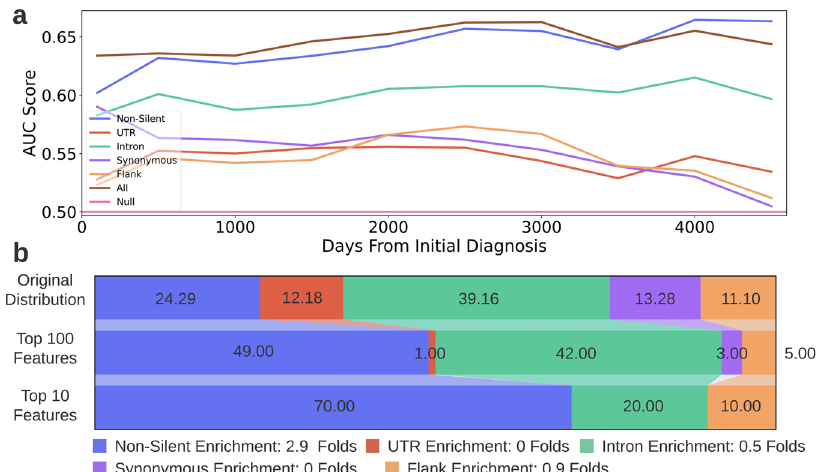
Fig. 9 Survival estimation results. a AUC scores achieved by the six RSF models for various times after the initial cancer diagnosis. The x -axis depicts the days passed since the diagnosis and the y -axis depicts the AUC score achieved by the models. Each colored curve denotes a different dataset. The horizontal line depicts the AUC score of a null model. b Feature-type distribution of the all features dataset and of the top ranked features chosen in the survival probability estimation task. Feature-type distribution of the all features dataset* (top row), top ranked 100 features (middle row) and top ranked 10 features (bottom row). The feature rankings were obtained from the all features model. The legend indicates the enrichment in the amount of each feature-type in the top 10 features compared to its original amount in the all features dataset (ratio between bottom and top row). *Note: The distribution depicted in the top row is the distribution of the all features dataset after it underwent preprocessing relevant for the survival estimation task. Table 2. The top 10 ranked features for estimating patients ’ survival probability. Rank Feature type